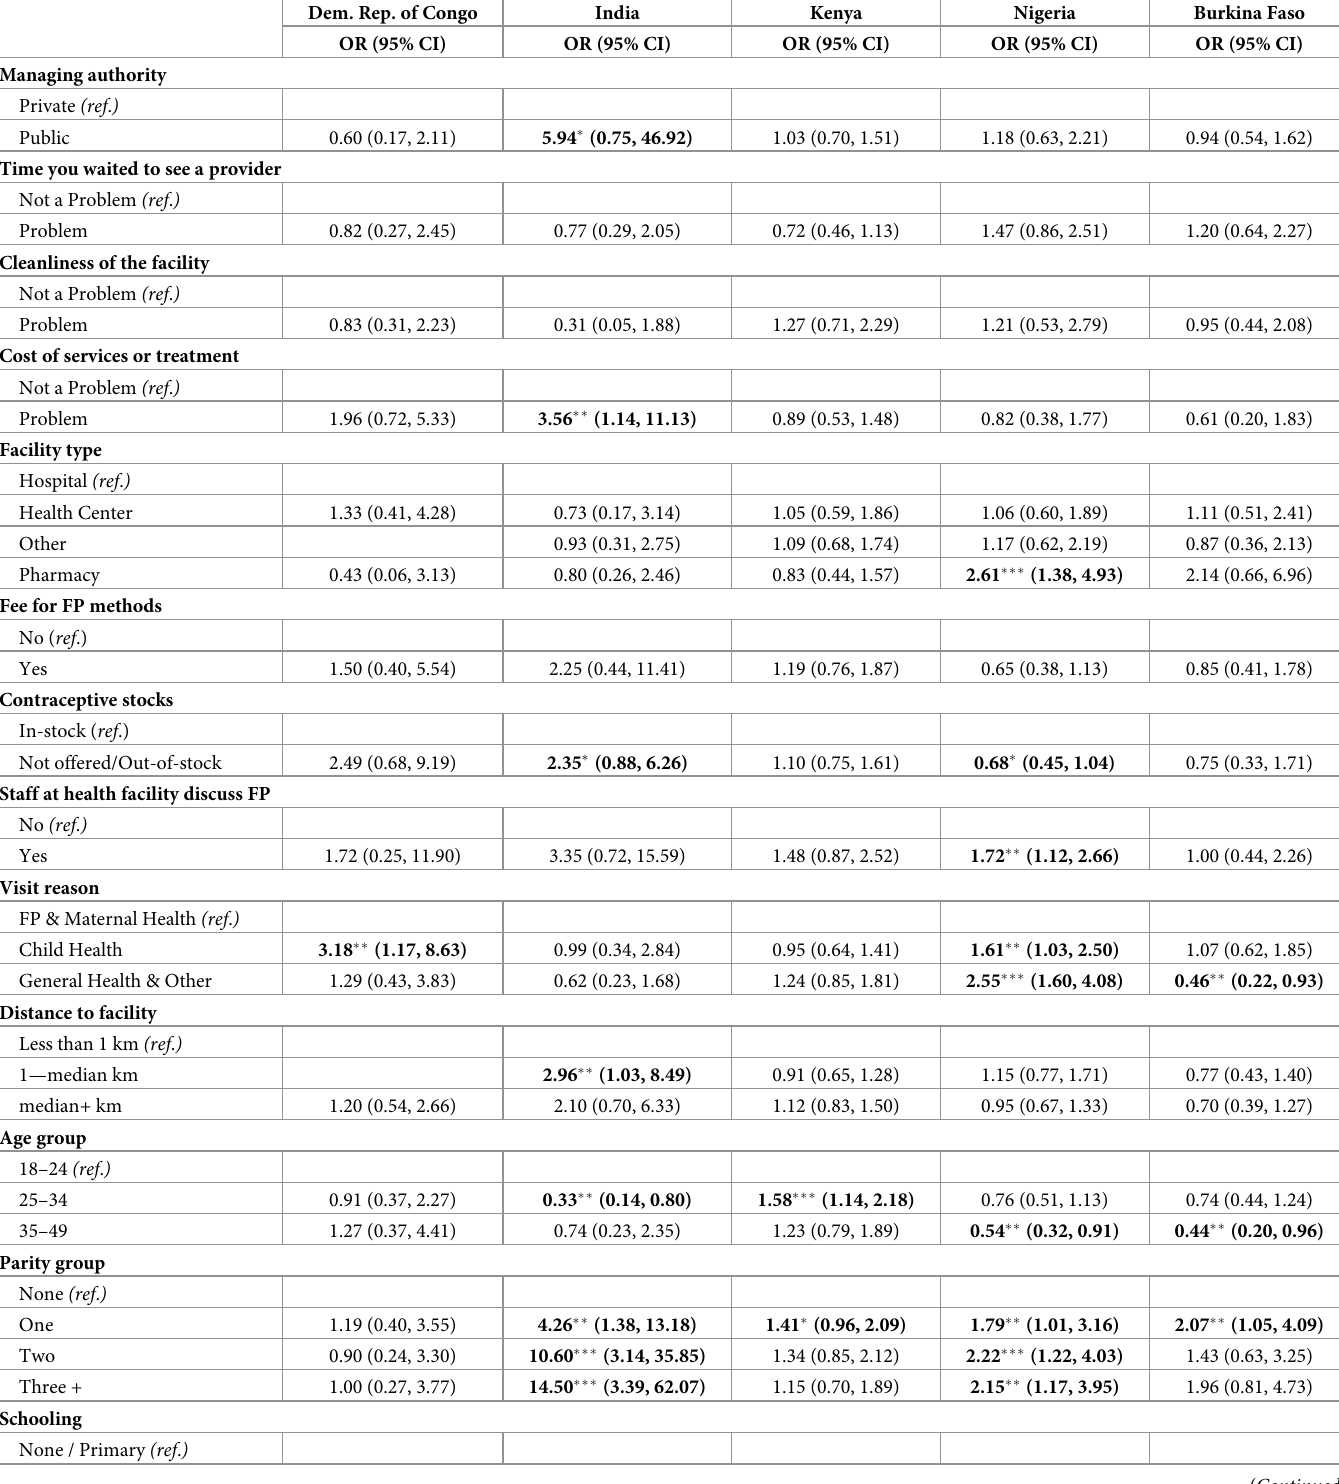
Table 3. Logistic regression model of service delivery point and individual characteristics associated with the probability that a client becomes an adopter over a continued nonuser in the Democratic Republic of Congo, India, Kenya, Nigeria, and Burkina